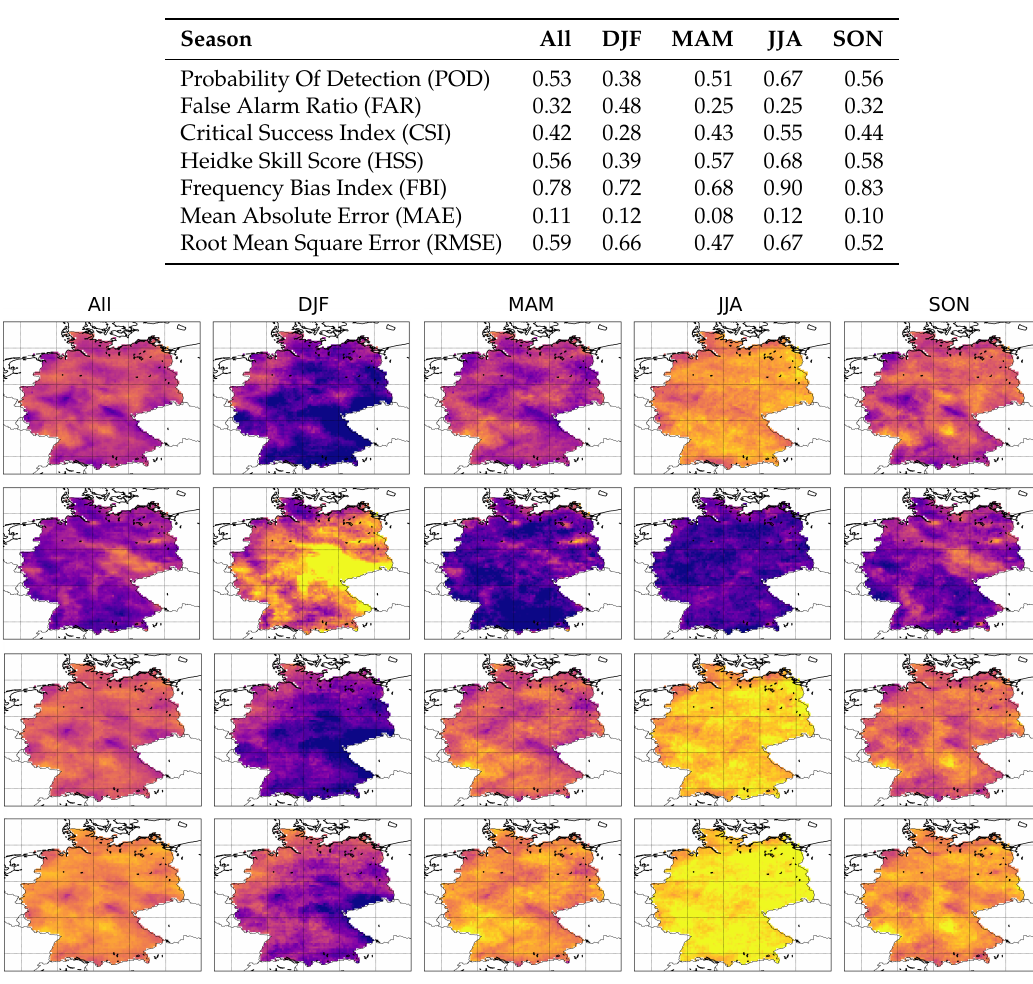
Figure 7. Categorical indices POD, FAR, CSI, and HSS for the total review period, DJF, MAM, JJA, and SON